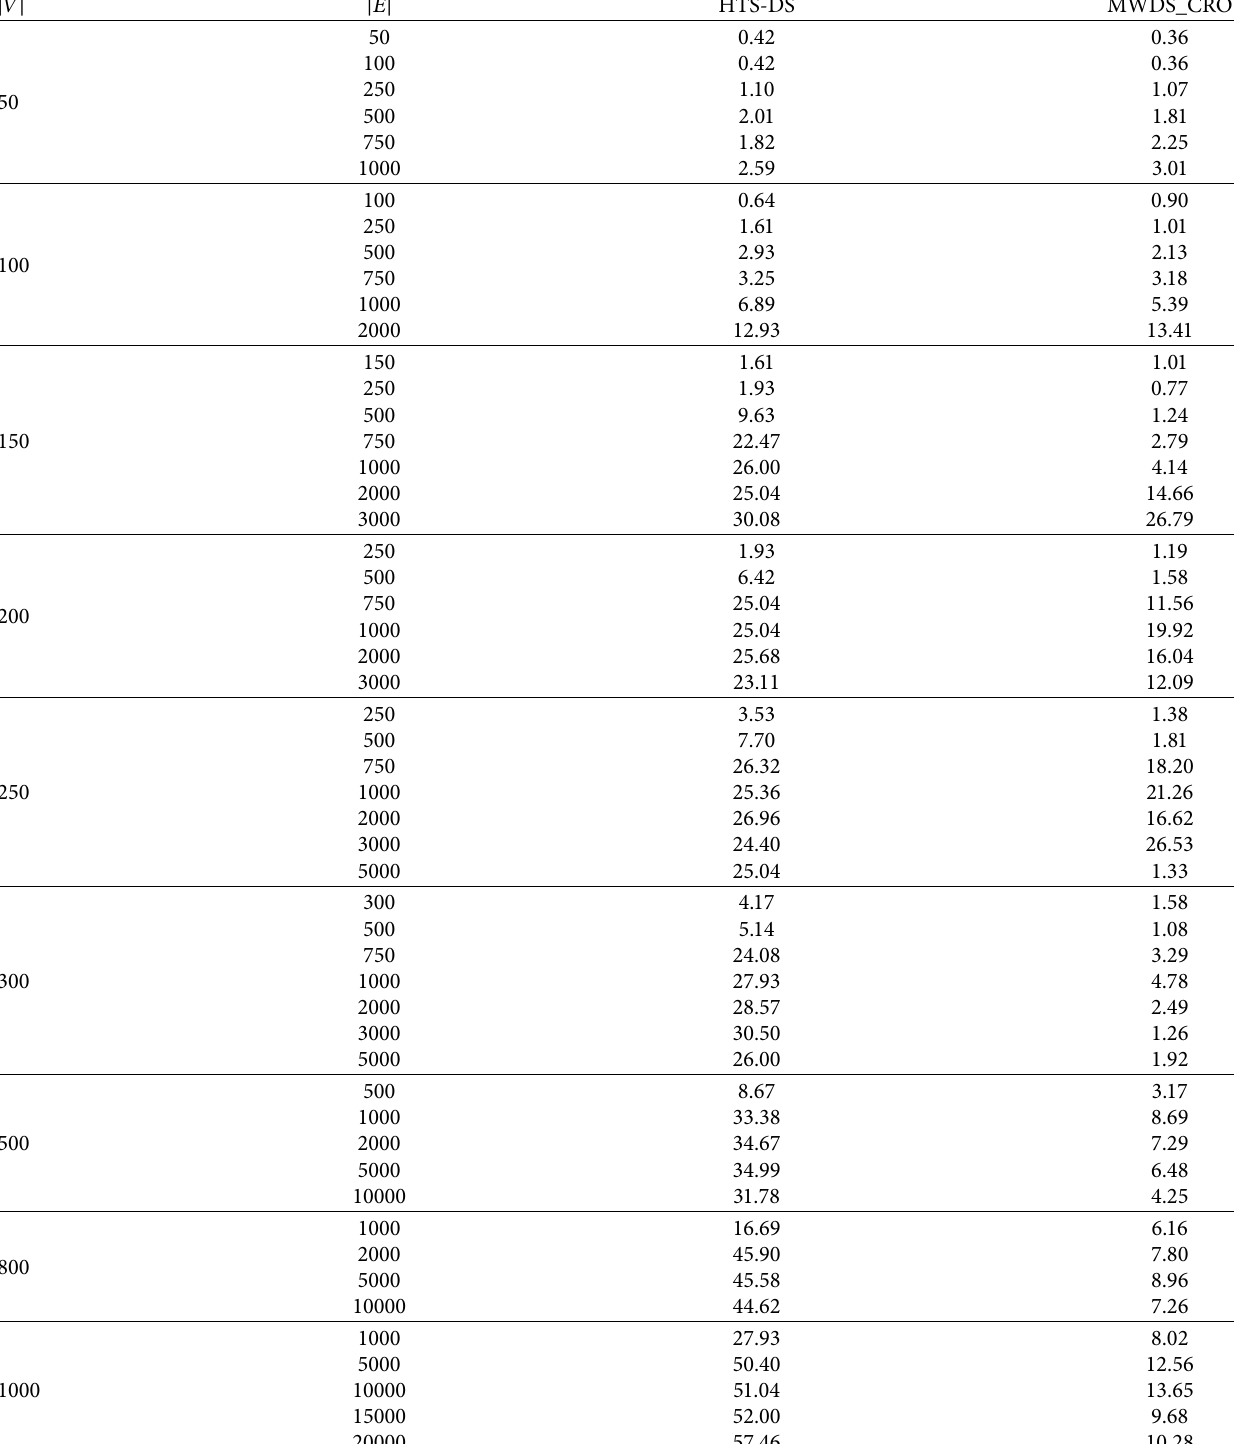
Table 8: Type TI-run time comparison in second of MWDS_CRO with the recent state-of-the-art algorithm. | V